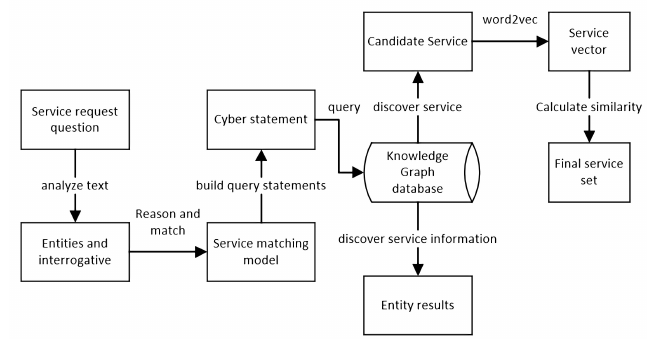
Figure 1. Overview of the SDKG